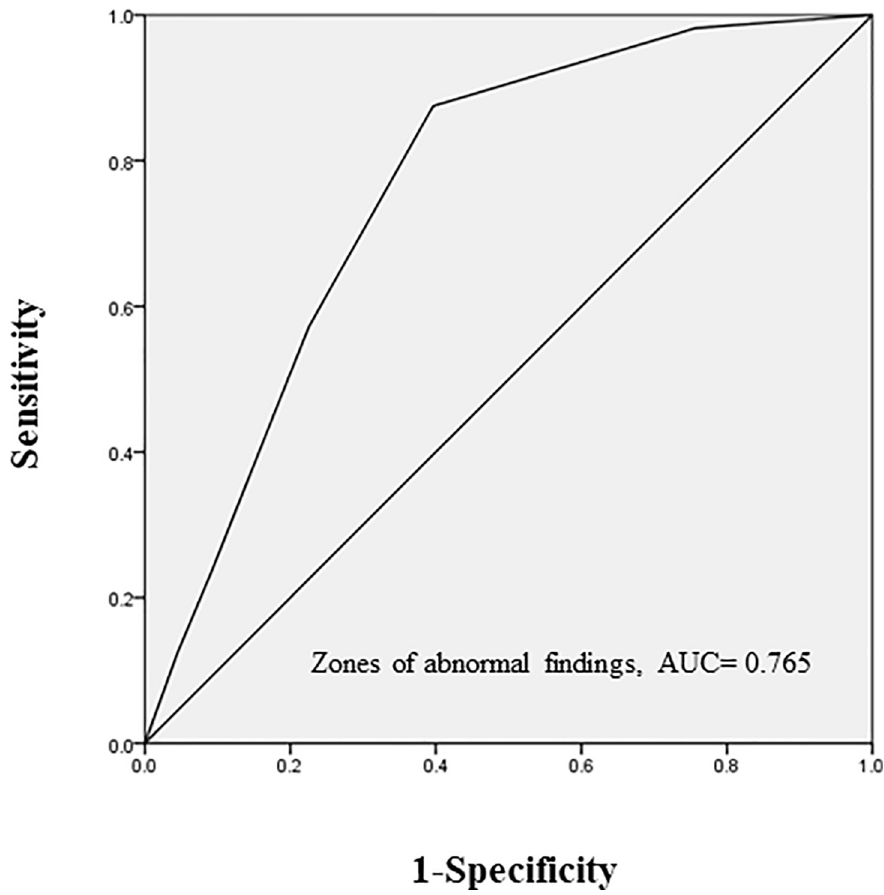
Fig 4. The radiological aggravation prediction model: ROC curve. ROC: receiver operating characteristic. AUC: area under the curve, Cut-off value: 3, sensitivity 87.5%, specificity 60.4%.